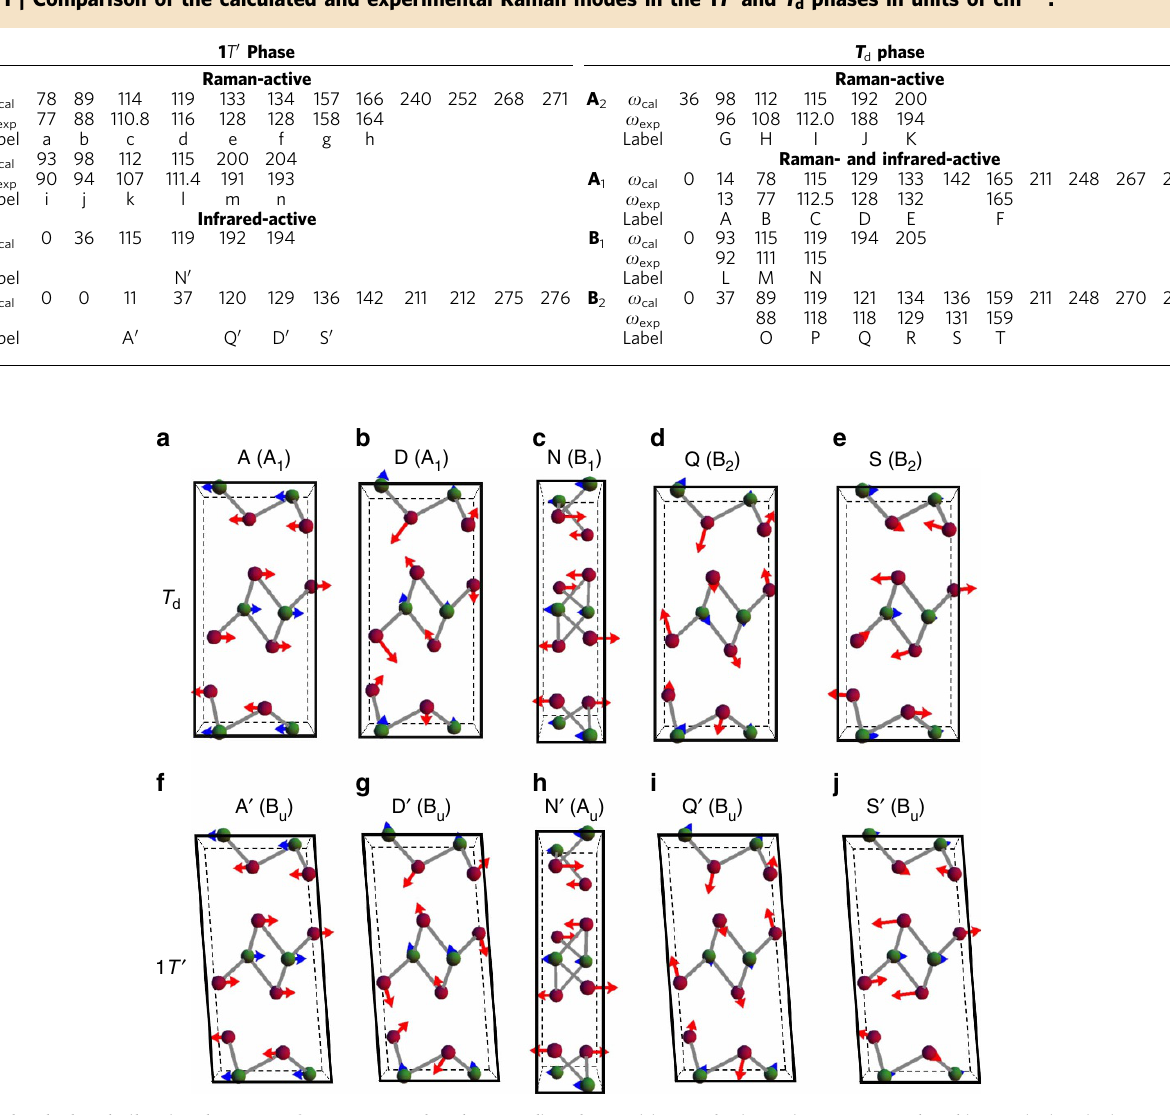
Figure 3 | Calculated vibrational patterns for Raman modes that are directly sensitive to the inversion symmetry breaking. Calculated vibrational patterns in the T d phase ( a – e ) and corresponding B u and A u modes in the 1 T 0 phases ( f – j ). A, D, Q and S modes vibrate in the bc plane and N mode in the ac